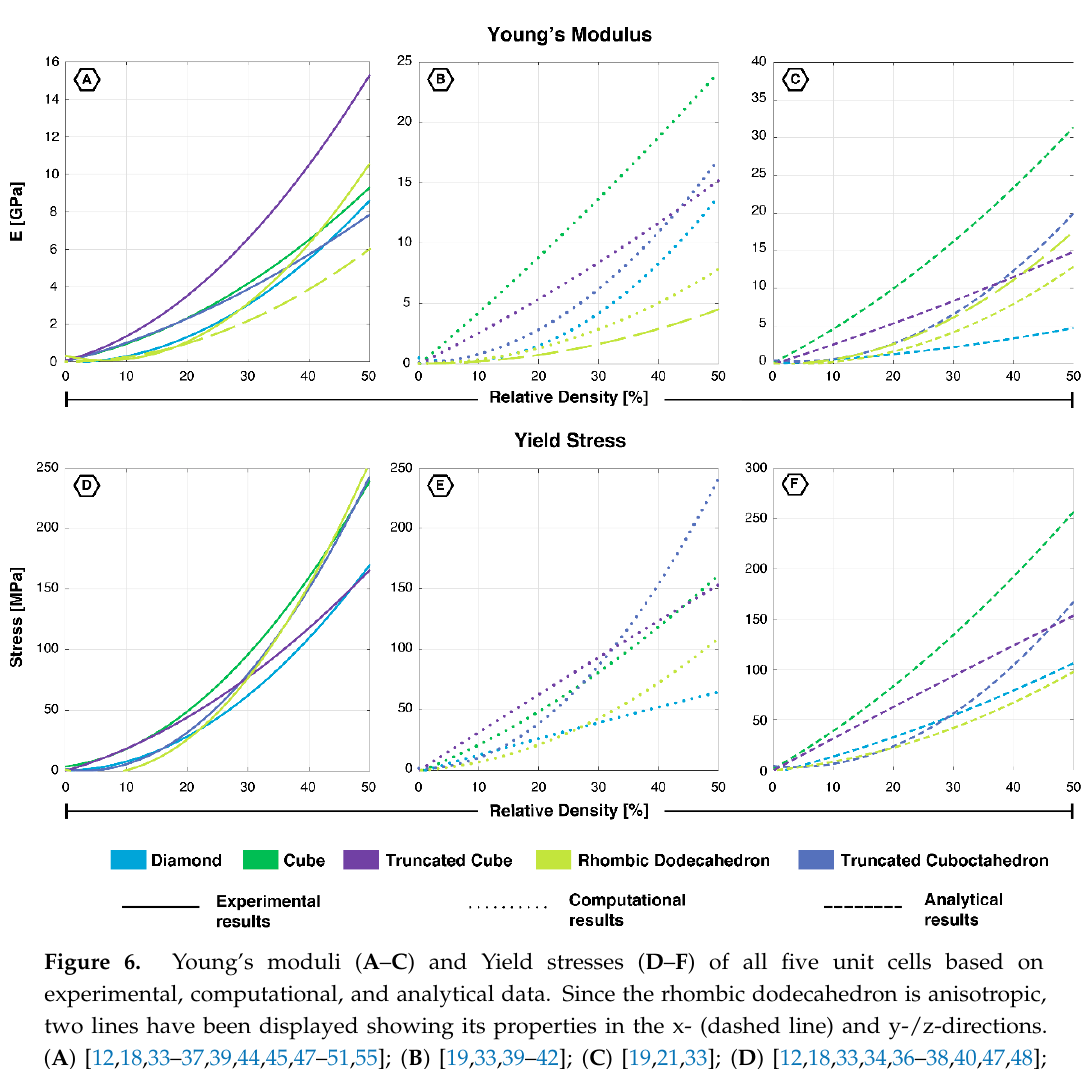
Figure 6. Young’s moduli ( A – C ) and Yield stresses ( D – F ) of all five unit cells based on experimental, computational, and analytical data. Since the rhombic dodecahedron is anisotropic, two lines have been displayed showing its properties in the x- (dashed line) and y-/z-directions. ( A ) [12,18,33–37,39,44,45,47–51,55] ; ( B ) [19,33,39–42] ; ( C ) [19,21,33] ; ( D ) [12,18,33,34,36–38,40,47,48] ; ( E ) [19,22,40] ; ( F ) [19,21,33] .